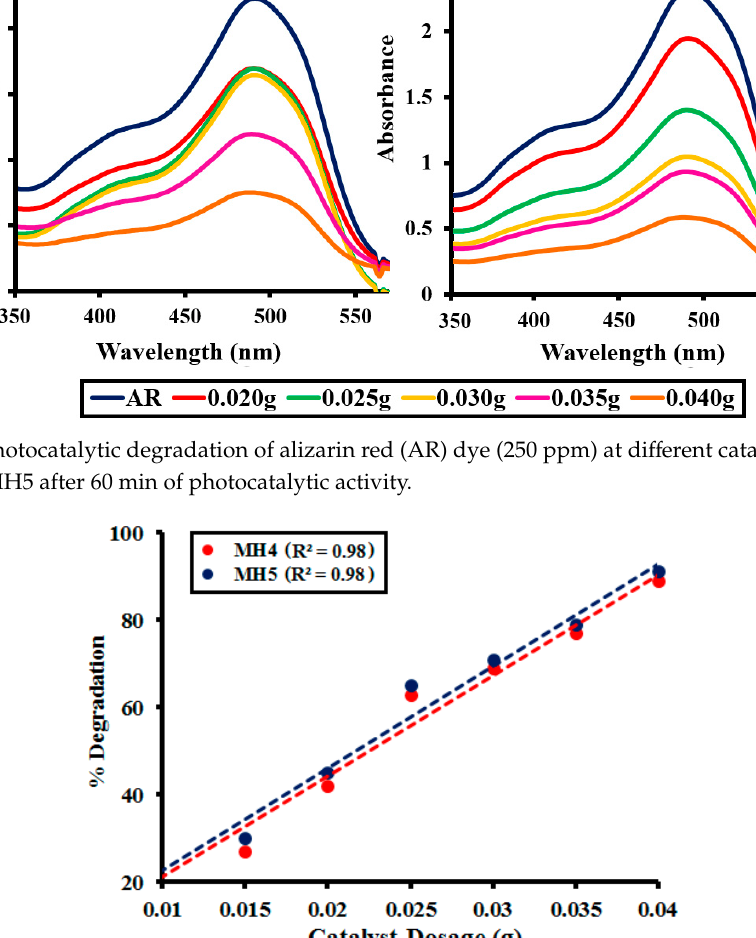
Figure 7. Correlation between different catalyst doses of MH4 and MH5 and percentage degradation of alizarin red (AR) Dye (250 ppm) after 60 min of photocatalytic activity.